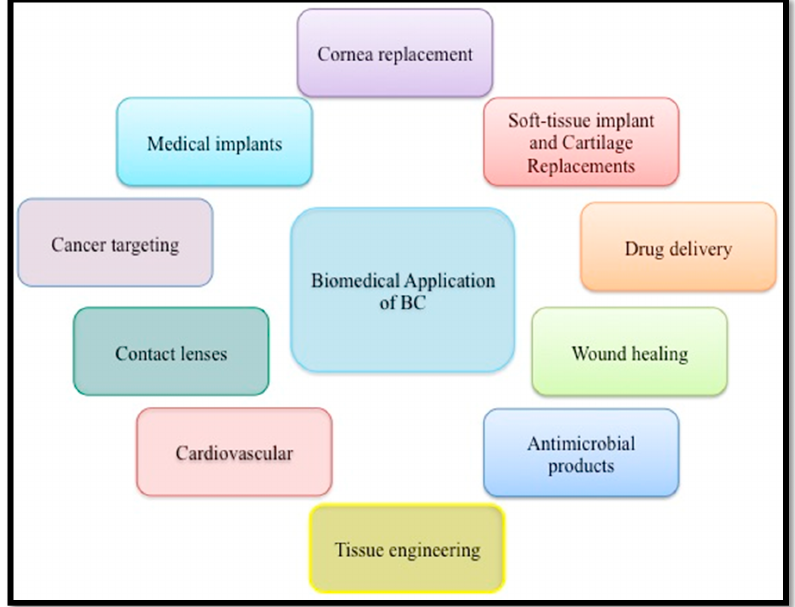
Figure 5. Biomedical applications of BC.